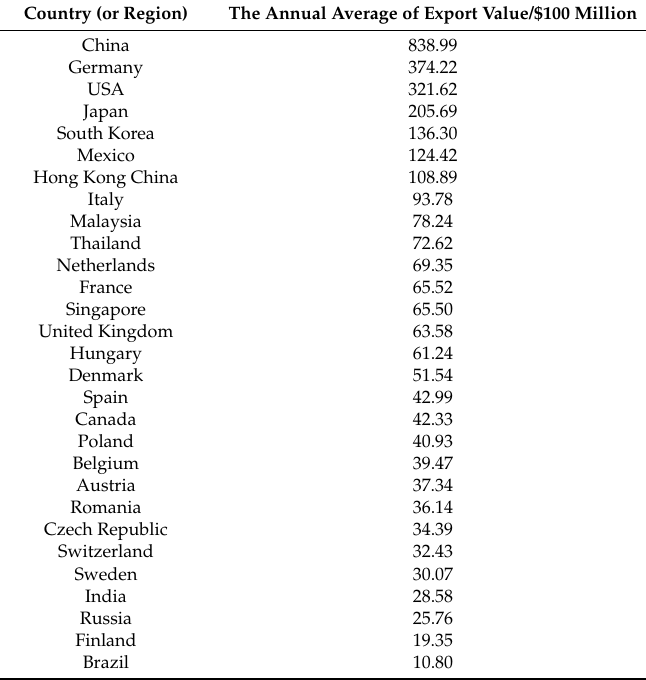
Table A1. The world’s major renewable energy products (REPs) exporters from 2007 to 2016.